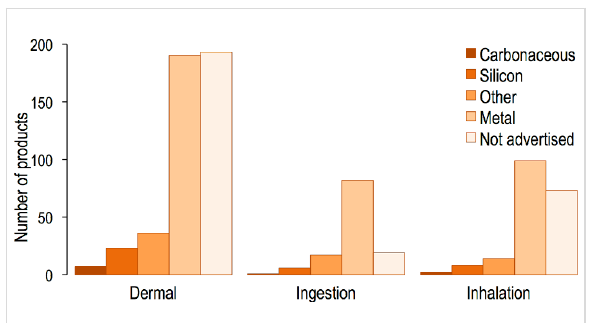
Figure 7: Potential exposure pathways from the expected normal use of consumer products, grouped by major nanomaterial composition